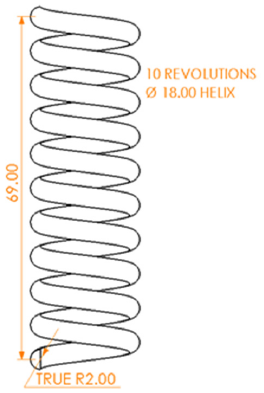
Figure 4. Helical channel–side